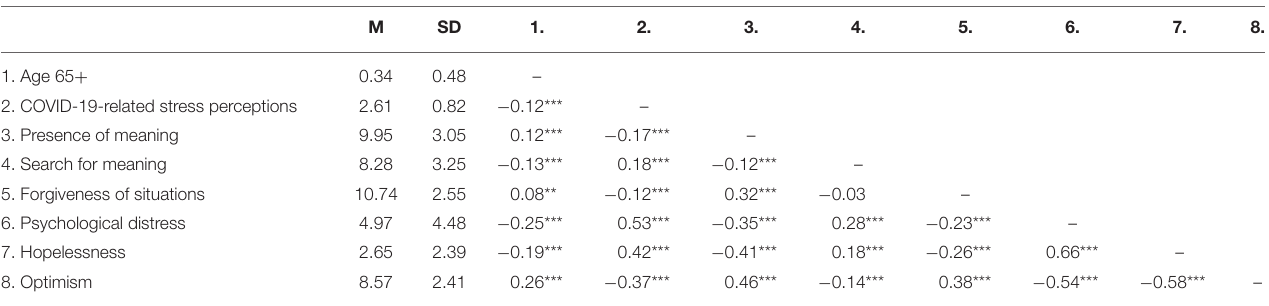
TABLE 2 | Descriptive statistics and bivariate correlations for main study